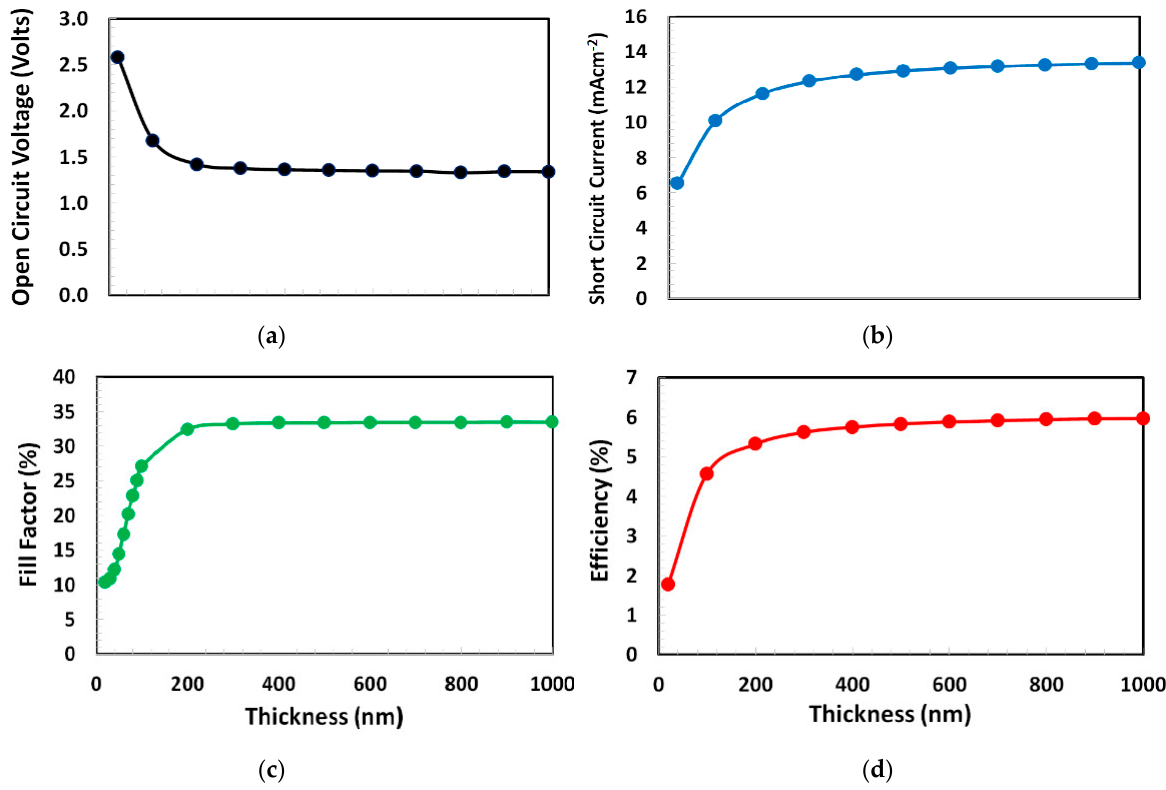
Figure 2. ( a ) Open-circuit voltage, ( b ) short-circuit current, ( c ) fill-factor, and ( d ) power-conversion efficiency of proposed solar cell Ag/BCP/PCBM/Cs 2 TiBr 6 /NPB/ITO as a function of PCBM layer thickness from 10 to 1000 nm.